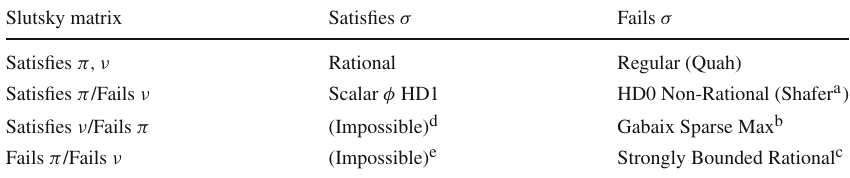
Table 1 Consumer behavior